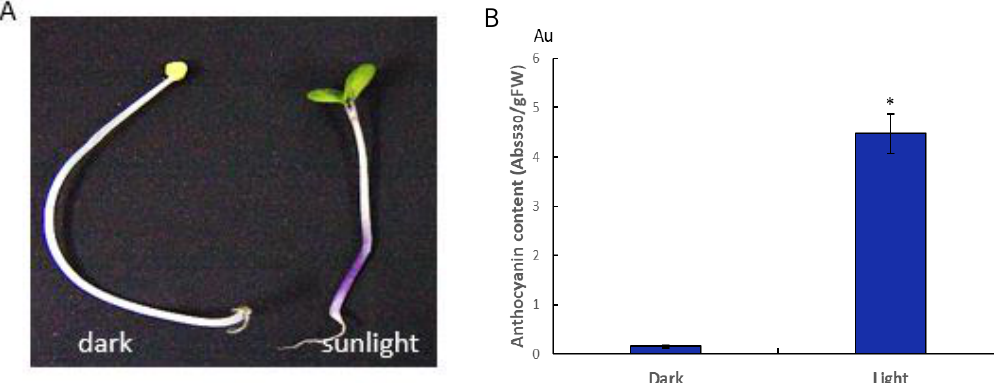
Figure 1. The phenotype of Brassica rapa subsp. rapa cv. Tsuda seedling and anthocyanin content after dark and sunlight treatment. ( A ) Seedlings were exposed to sunlight or darkness. ( B ) Anthocyanin was extracted from fresh whole seedlings, and the concentration was determined using absorbance at 530 nm per gram of fresh mass. Vertical bars indicate ± SE of replicate assays ( n = 8). The statistically significant difference between light treatment and dark is shown ( t -test, * p < 0.05).